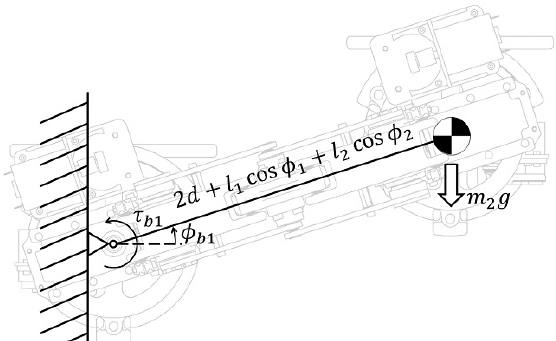
Figure 6. A schematic figure of the simplified model regarding the base actuator.